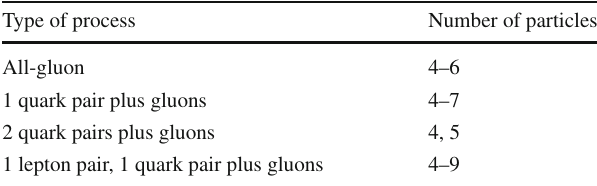
Table 1 The types of processes available in Vincia ’s MHV library Type of process Number of